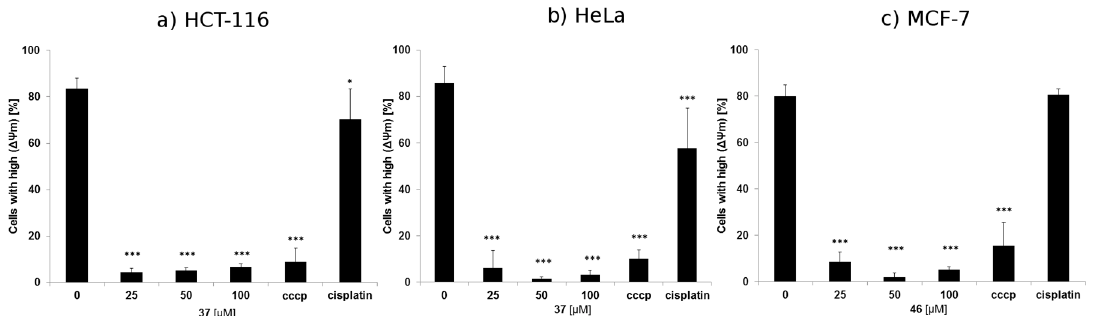
Figure 5. Mitochondrial membrane potential ( ∆ ψ m ). Cytometric analysis of ∆ ψ m with 2.5 µ g/mL JC-1 in: HCT-116 ( a ), HeLa ( b ) treated with 37 (0–100 µ M) 24 h, carbonyl cyanide m -chlorophenylhydrazone (CCCP) (100 µ M) for 15 min or cisplatin (100 µ M) 24 h; MCF-7 ( c ) treated with 46 (0–100 µ M) 24